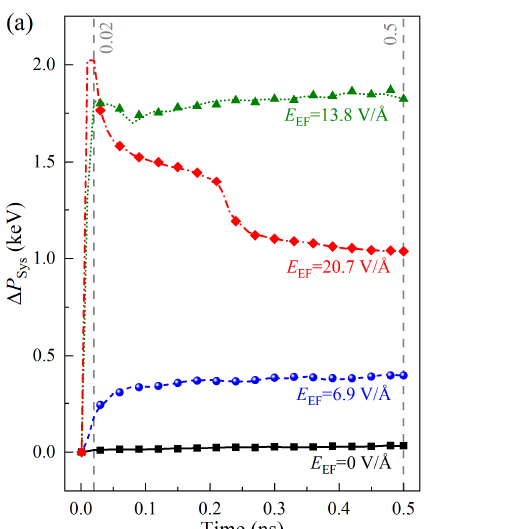
Figure 2. Variation of potential energy (VPE, Equation (1)) of the system under the electric field with different intensities ( E EF ) in Stage II. ( a ) VPE curves, ( b ) representative snapshots of the system with A-30 CTT as the channel. The initial concentration of NaCl in solution ( C NaCl ) in the source reservoir Ω 1 is 0.6 mol/L.